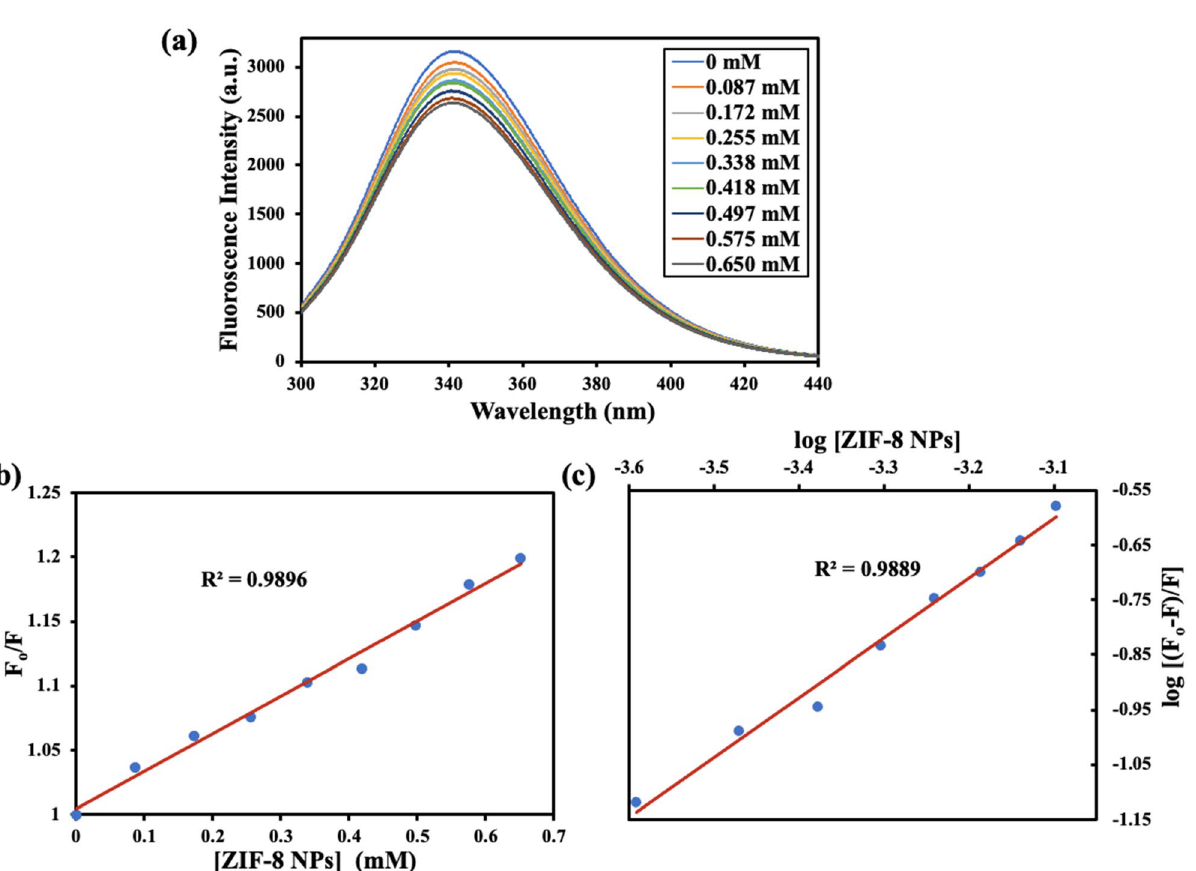
Figure 4. ( a ) Steady-state fluorescence spectra of BSA showing quenching of fluorescence with increasing concentration of ZIF-8 NPs. ( b ) The plot of F o /F versus [ZIF-8 NPs] (Stern–Volmer plot). ( c ) The plot of log [(F o − F)/F] vs. log [ZIF-8 NPs] (double-logarithmic